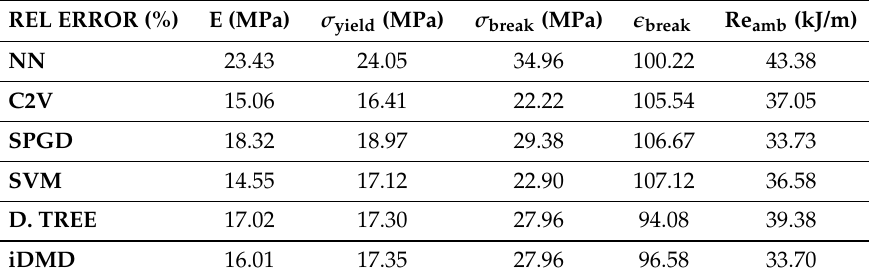
Table 4. Relative error for different regression